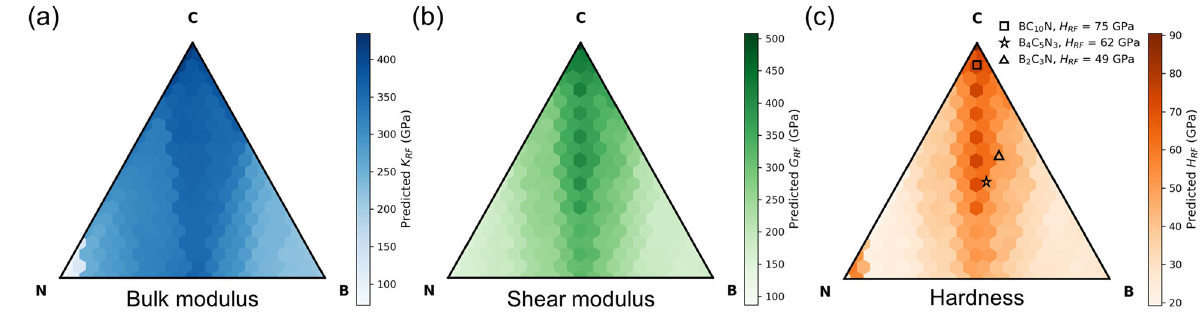
Fig. 4 Triangular graphs from machine learning prediction. B-C-N ternary graphs for a bulk modulus ( K ), b shear modulus ( G ), and c hardness ( H ), predicted by random forests (RF) machine learning models. c indicates that a 1:1 B-N composition ratio can lead to various superhard compounds such as BC 2 N ( H RF = 74 GPa) and BC 4 N ( H RF = 65 GPa). The hardness of three proposed superhard compounds, BC 10 N, B